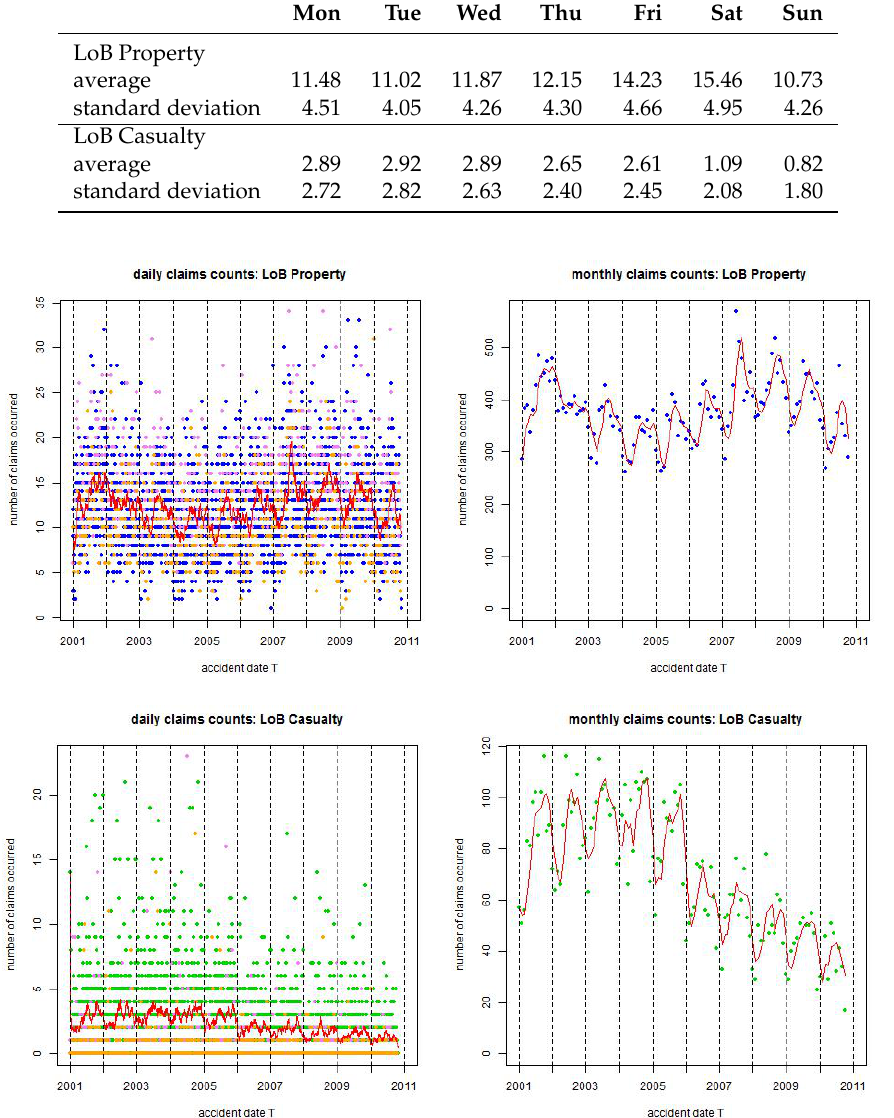
Figure 1. Observed claims counts from 1/1/2001 until 31/10/2010: (top) LoB Property colored blue and (bottom) LoB Casualty colored green. The lhs gives daily claims counts and the rhs monthly claims counts; the red lines are the rolling averages over 30 days on the lhs and over 2 months on the rhs; violet dots show claims occurrence on Saturdays and orange dots claims occurrence on Sundays, the resulting statistics are provided in Table